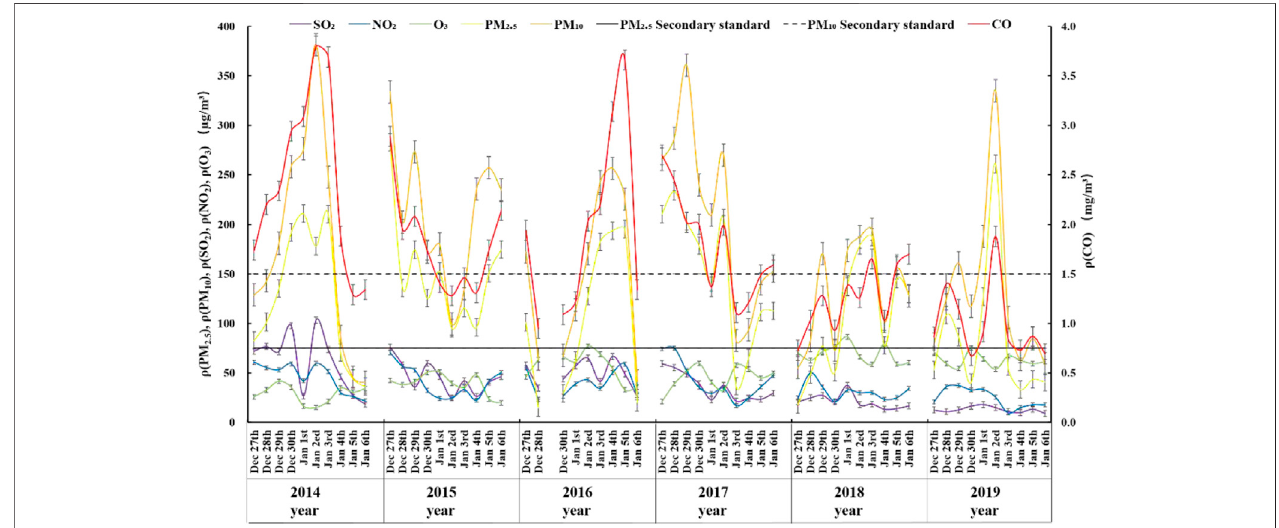
FIGURE 4 | Daily trend of average concentration of main pollutants in Zhengzhou during the Spring Festival from 2014 to 2019.